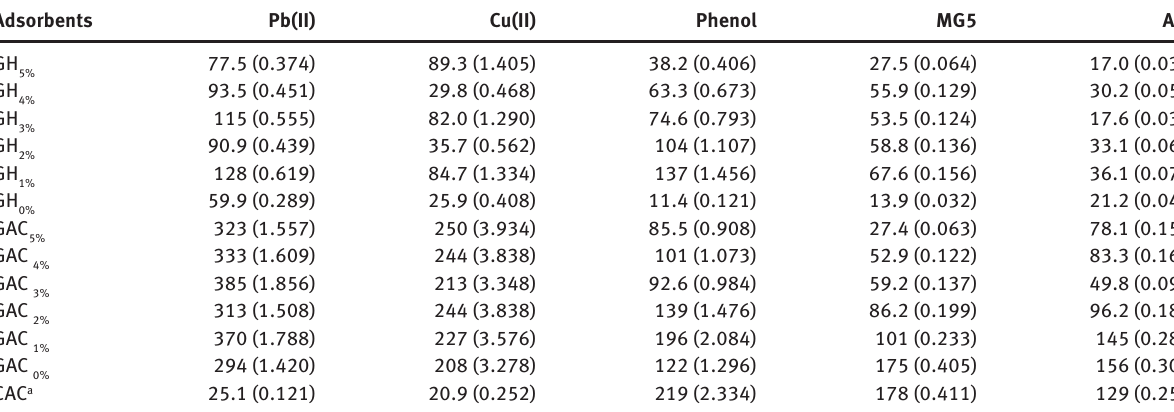
; mg/g) of the glucose-derived hydrochar (GH), glucose-activated carbon (GAC) Table 2: Maximum monolayer adsorption capacities ( Q o max and CAC samples toward Pb 2 + , Cu 2 + , phenol, methylene green 5 (MG5), and acid red 1 (AR1).